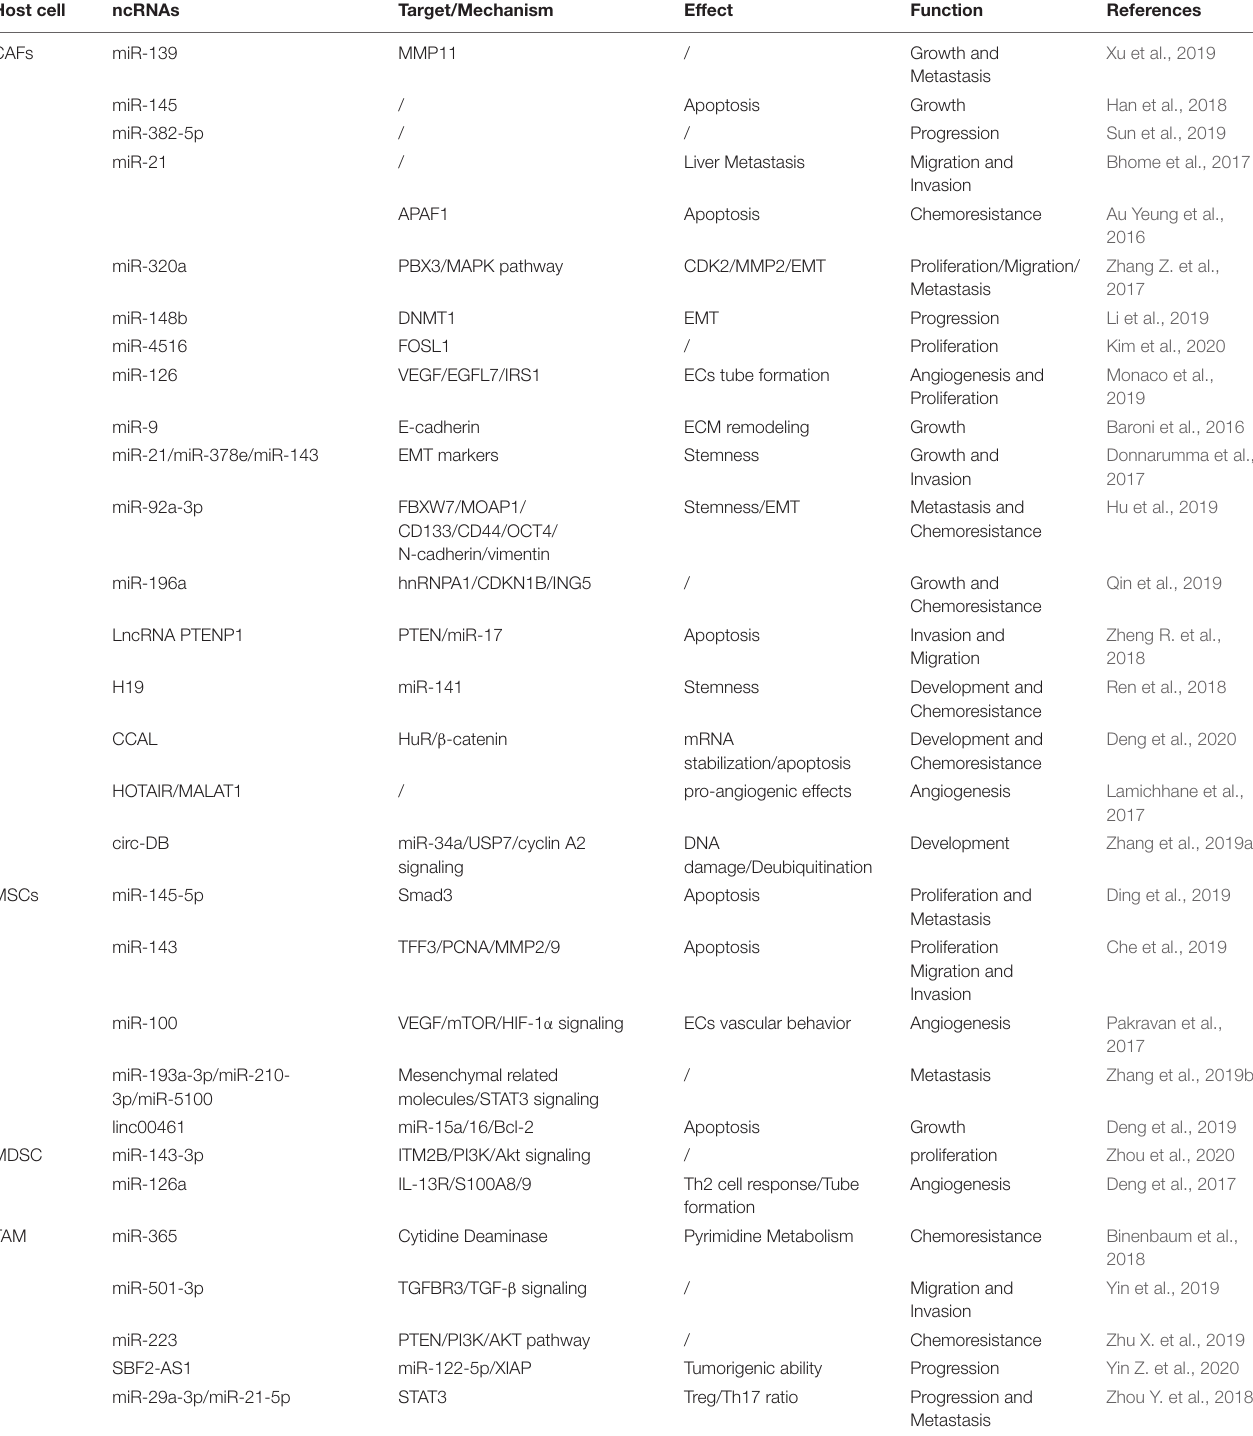
TABLE 2 | Roles of stromal cell-derived exosomal ncRNAs in tumor